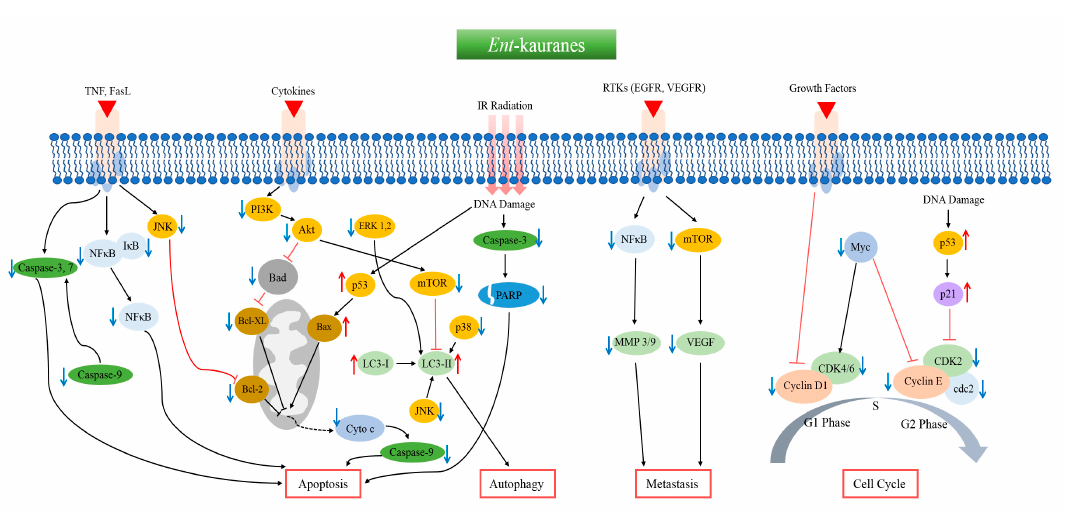
Figure 3. The common biological targets and mechanistic pathways of anticancer ent -kaurane